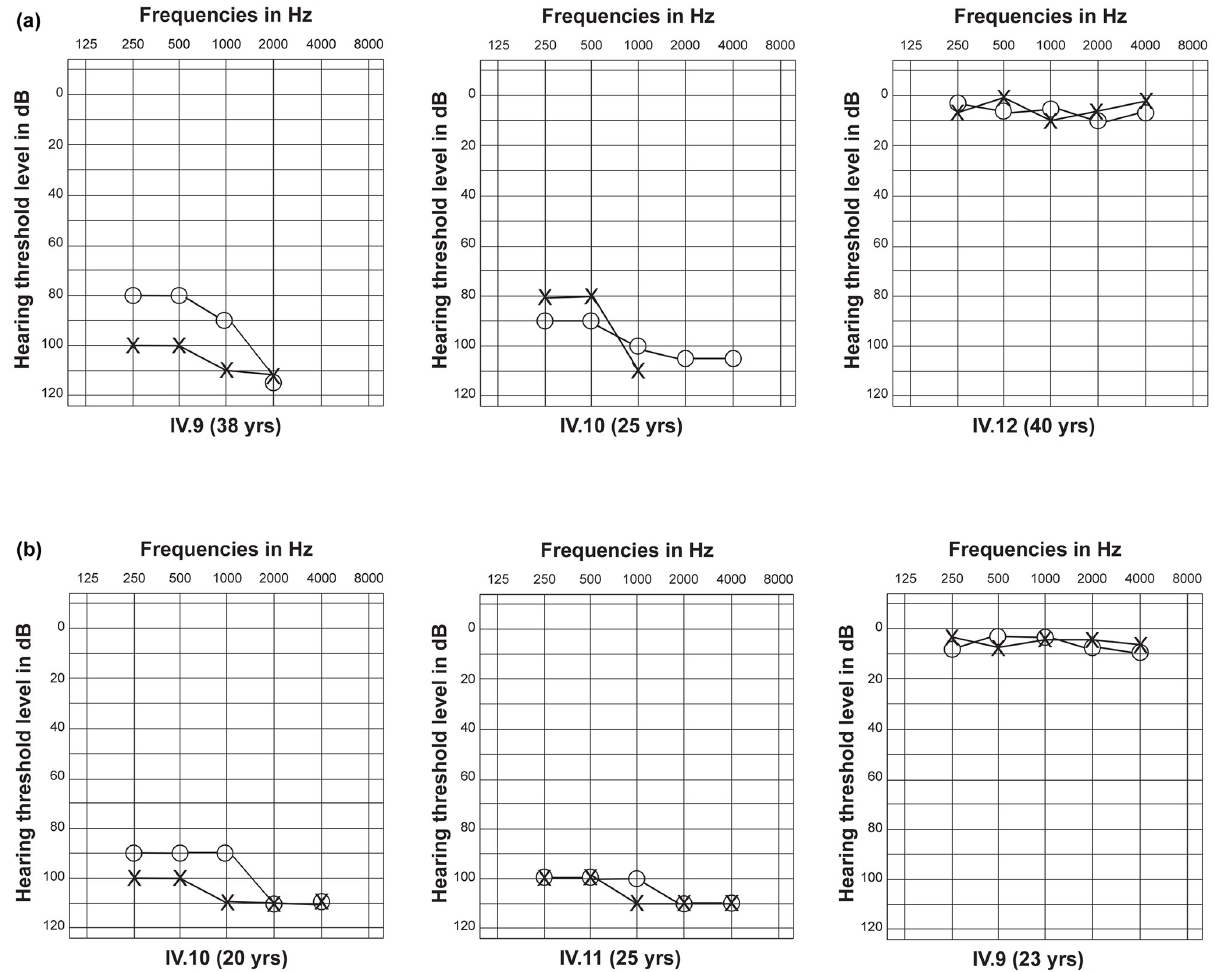
Fig 2. Audiograms of affected and normal individuals of NKDF01 and NKDF08. (a) Audiograms of two older affected individuals IV:9, IV:10 and a normal individual IV:12 of family NKDF01. Circles and crosses are representing the hearing thresholds for right and left ears respectively. Audiograms of both the affected individuals are depicting severe to profound hearing loss while the audiogram of normal individual (IV:12) is showing the normal threshold for hearing. (b) Audiograms of two older affected individuals IV:10, IV:11 and a normal individual IV:9 of family NKDF08. Audiograms are showing that both the affected individuals are having severe to profound hearing loss while the audiogram of normal individual (IV:9) is showing the normal threshold for hearing.